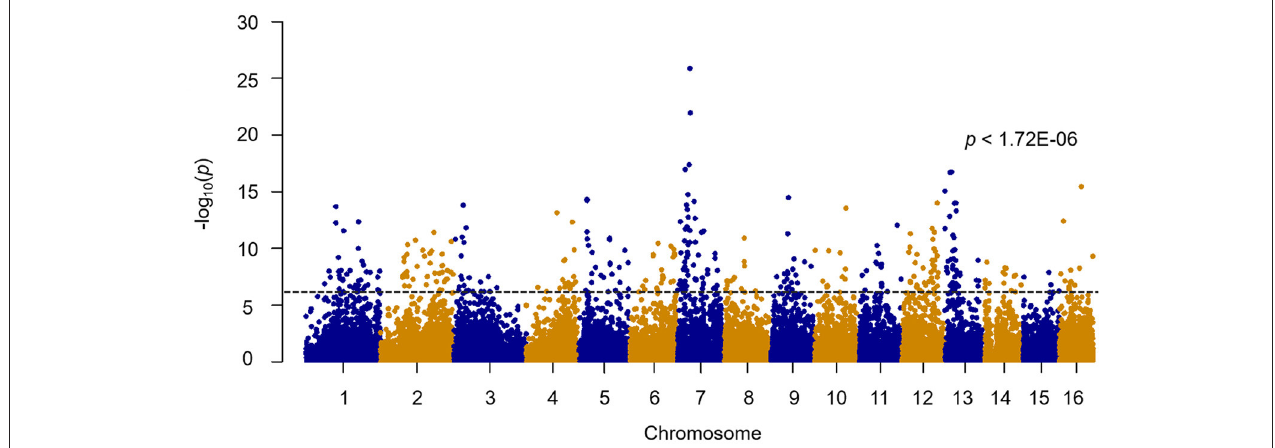
FIGURE 2 | Genome-wide association study (GWAS) of shell color with 29,036 single-nucleotide polymorphisms (SNPs) in bay scallops ( p < 1.72E − 06).